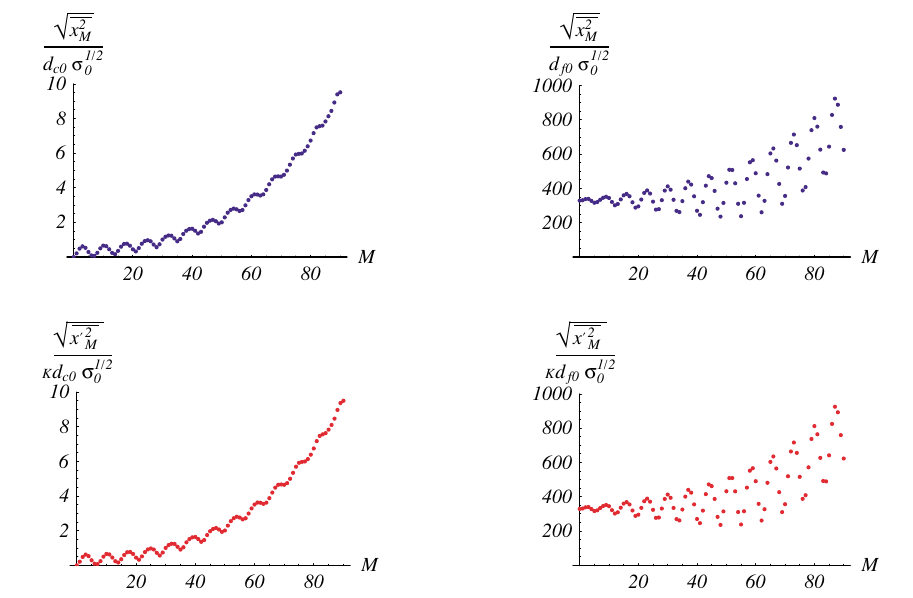
FIG. 1. (Color) Normalized rms lateral displacement (upper row, blue points) and angular divergence (lower row, red points) of a finite train of pointlike bunches at the exit of a representative linear collider due to misalignment of the cavities (left column) or focusing elements (right column). See Table I for the choice of parameters.